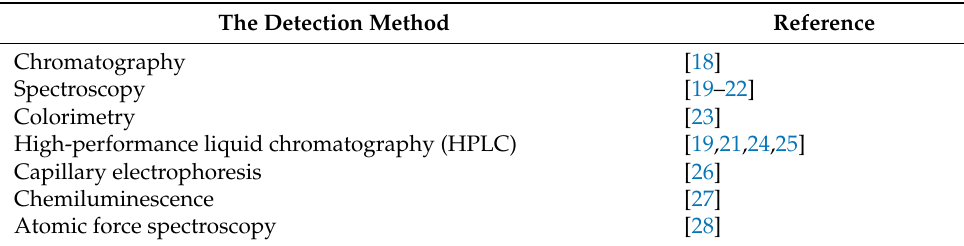
Table 1. Physicochemical methods used for L-TRP detection.